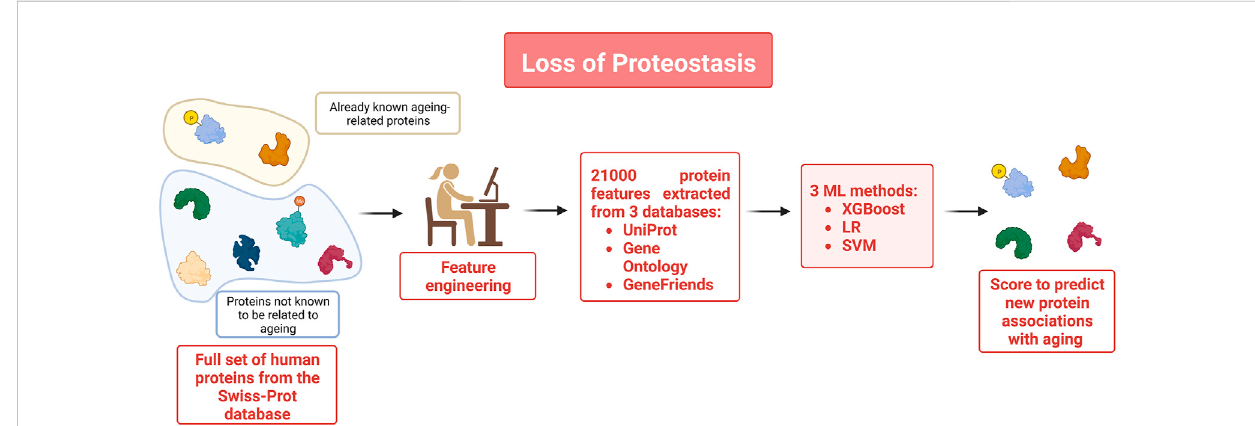
FIGURE 5 To identify senescent cells, this study relied on the fact that senescent cells elicit a very speci fi c morphology to generate a set of features using cell morphology images obtained by phase-contrast microscopy. The set of 50 × 50 pixels images were used to train a CNN as a classi fi er that could distinguish senescent cells from healthy cells with a greater accuracy than classical ML methods (SVM, RF, and